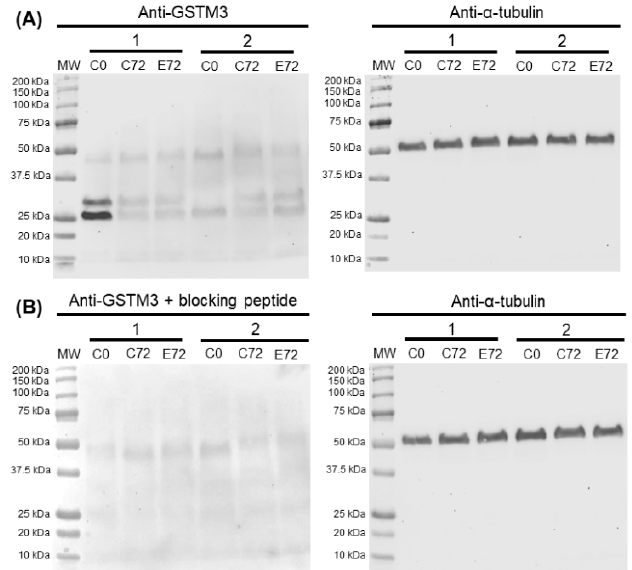
Figure 6. ( A ) Representative Western blots resulting from the incubation with the GSTM3 antibody (Anti-GSTM3) and its loading control ( α -tubulin). ( B ) Western blots resulting from incubation with the GSTM3 antibody with GSTM3-blocking peptide (Anti-GSTM3 + blocking peptide) and its loading control ( α -tubulin). Lanes MW: molecular weight. Lanes C0: control at 0 h of sperm liquid storage. Lanes C72: control at 72 h of sperm liquid storage. Lanes E72: EA-treated samples at 72 h of liquid storage.